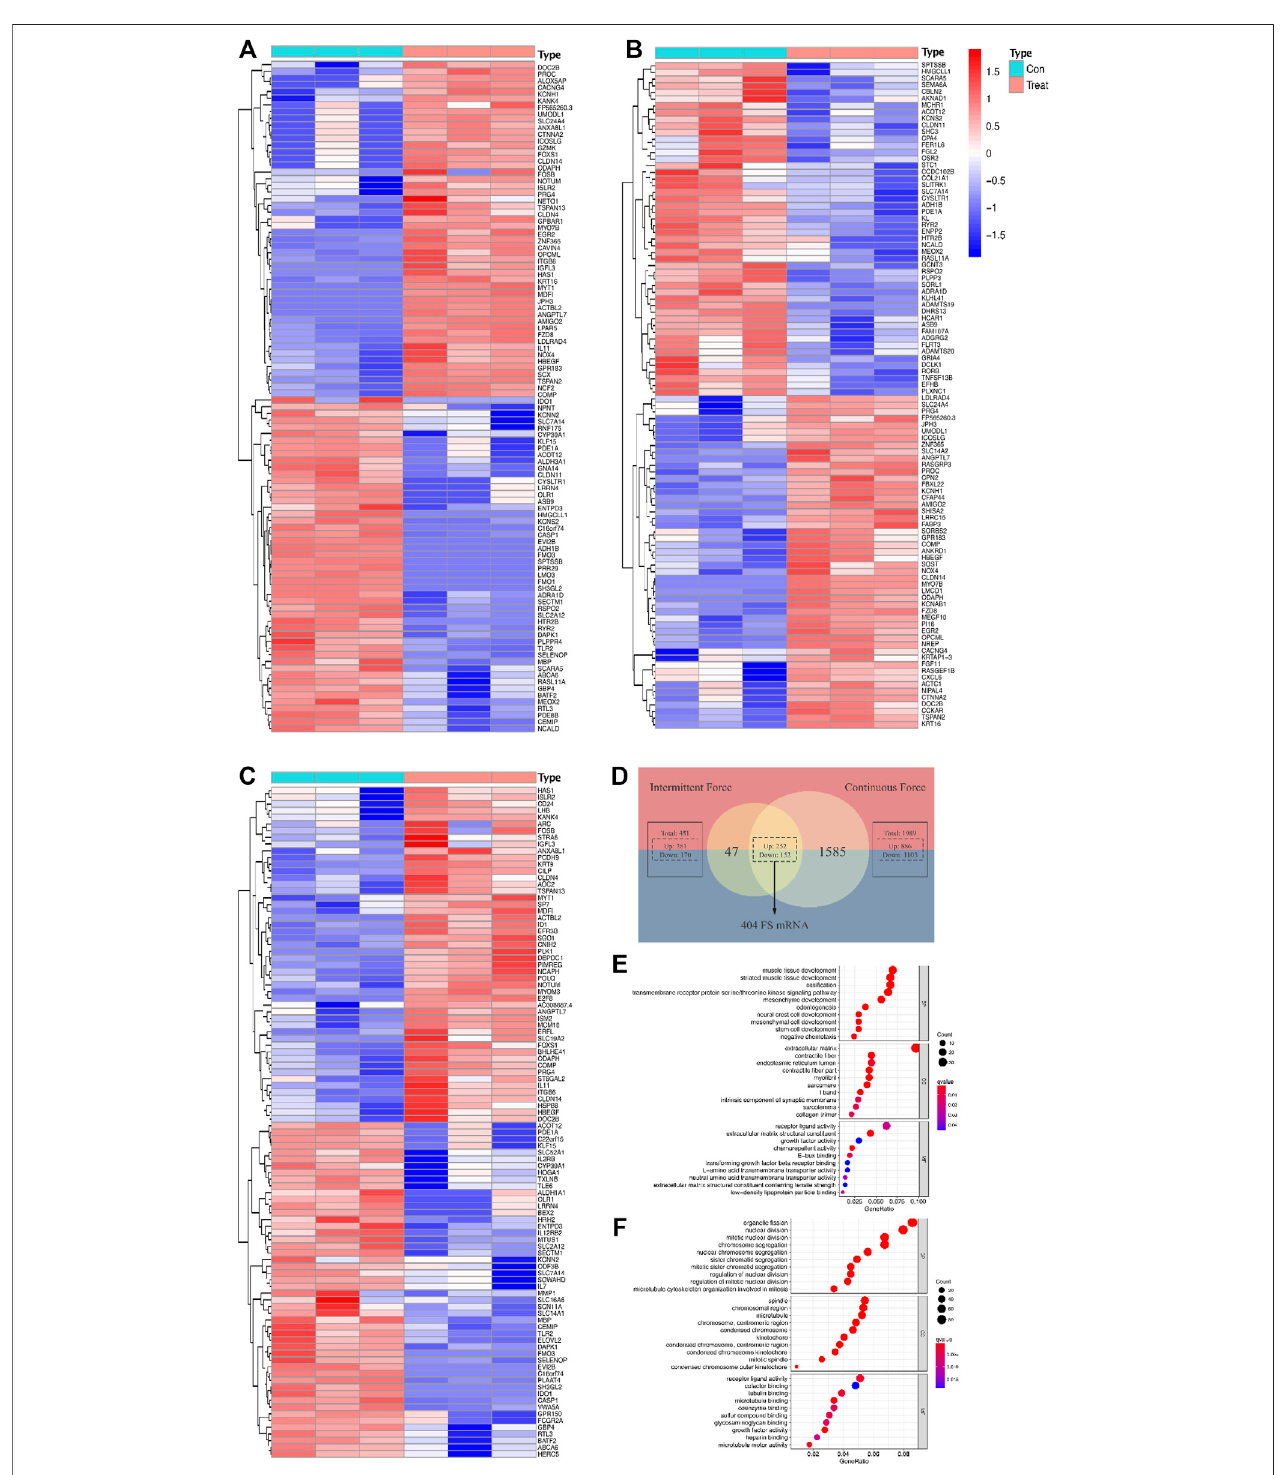
FIGURE2| Differentiallyexpressedpro fi lesandfunctionalanalysisofmRNAsinaforce-relatedway.Heatmapsdisplaythetop50geneswiththehighestvaluesof| log2foldChange (FC)| in the intermittent force group (A) , static force group (B) , and different force type group (C) . Intersection of results gained from two force groups contributes to the list of force-sensitive mRNA (FS mRNA), which is visualized by the VENNY diagram (D) . Top 10 GO annotations grouped by BP, CC, and MF of FS mRNAs (E) and FTS mRNAs (F) . GO terms are ranked by the GeneRatio scores. The size and color of the dots represent the gene count and q -value score of the enrichment analysis,